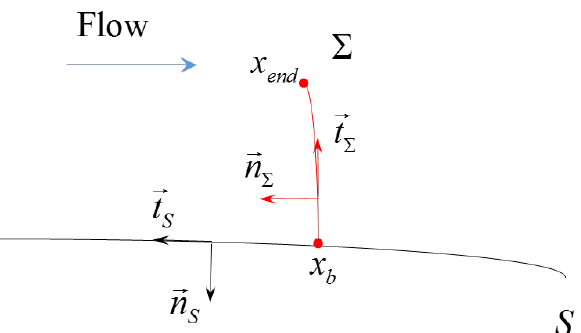
Figure 1. Scheme of shock location and conventions.